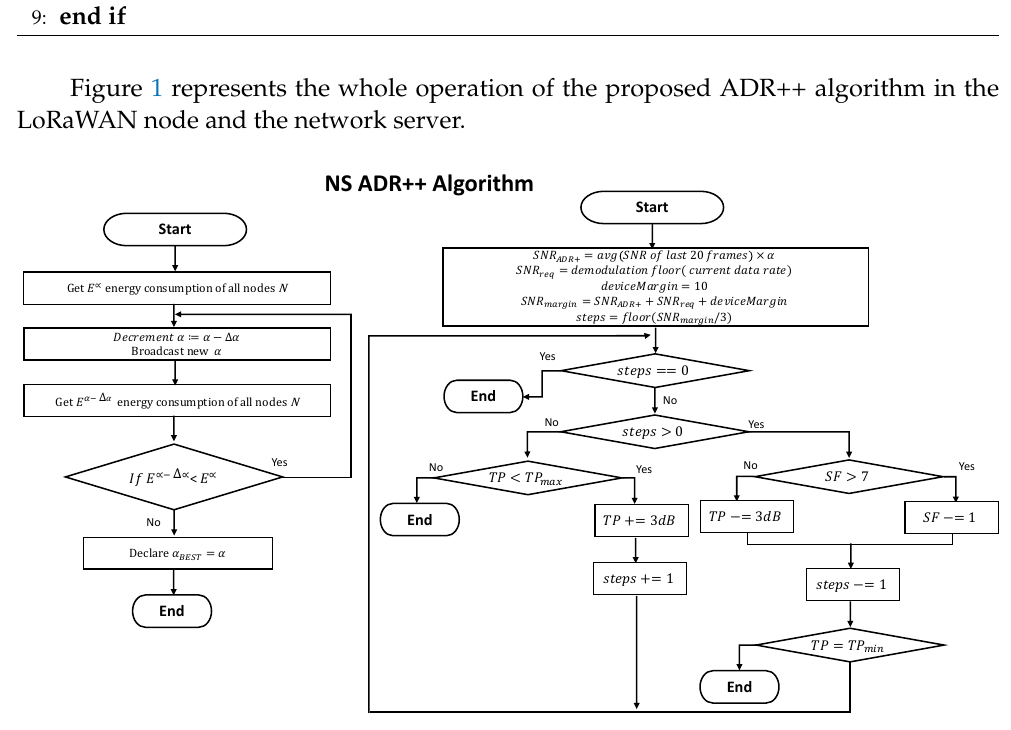
Figure 1. Flowchart of ADR++ algorithm operation in LoRaWAN network